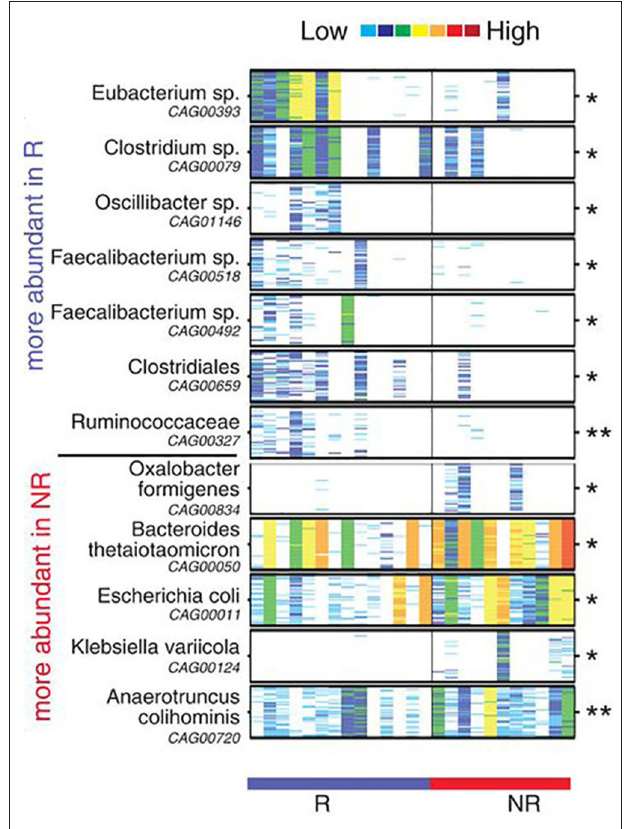
FIGURE 2 | Compositional differences in the gut microbiome are associated with responses to anti-PD-1 immunotherapy. Pairwise comparisons by MW test of abundances of metagenomic species (MGS) identified by metagenomic WGS in fecal samples ( n = 25): Responder (R) ( n = 14, blue), Non-responder (NR) ( n = 11, red). * p < 0.05, ** p < 0.01. Colors reflect gene abundances visualized using “barcodes” with the following order of intensity: white (0) < light blue < blue < green < yellow < orange < red for increasing abundance and each color change corresponds to a 4x fold abundance change. In these barcodes, MGS appear as vertical lines (co-abundant genes in a sample) colored according to the gene abundance [The figure is reprinted with permission from Gopalakrishnan et al.